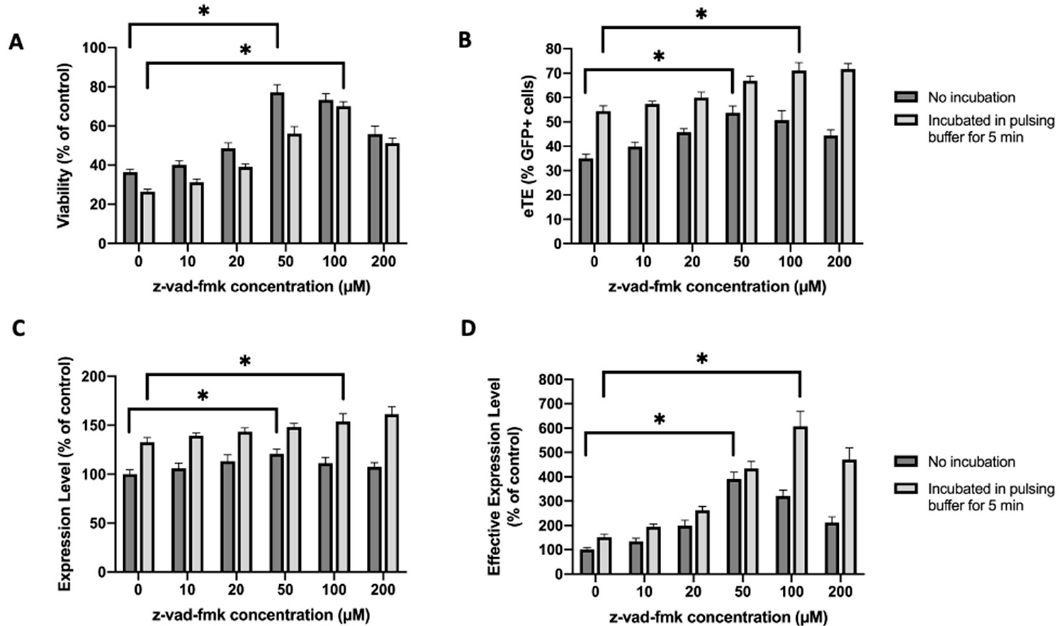
Figure 2. E ff ects of caspase inhibitor on cell viability and EGFP expression in Jurkat cells under two di ff erent experimental conditions. One (i.e., no incubation) was the same as that in Figure 1; the other was similar to the first one except that the cells were incubated in the pulsing bu ff er for 5 min before being treated with z-vad-fmk at di ff erent concentrations for 24 h. ( A ) Cell viability; ( B ) eTE; ( C ) expression level; ( D ) e ff ective expression level. Pulsing condition: 650 V / 0.2 cm, 400 µ s, 1 pulse. Error bars, SEM; * p < 0.05, Student’s t -test. N = 6.